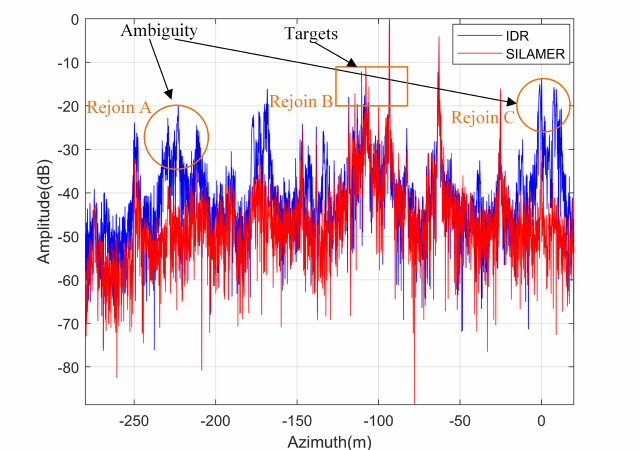
Figure 12. The azimuth profile of reconstruction results of the targets in Figure 11 by using IDR and